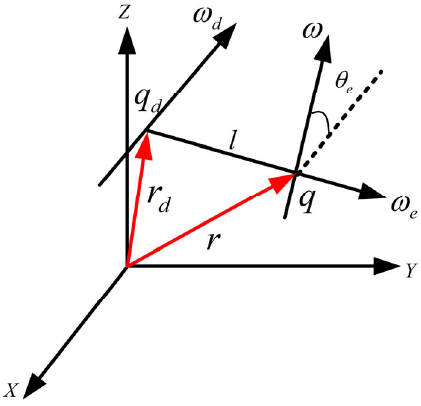
Figure 2. Error twist.